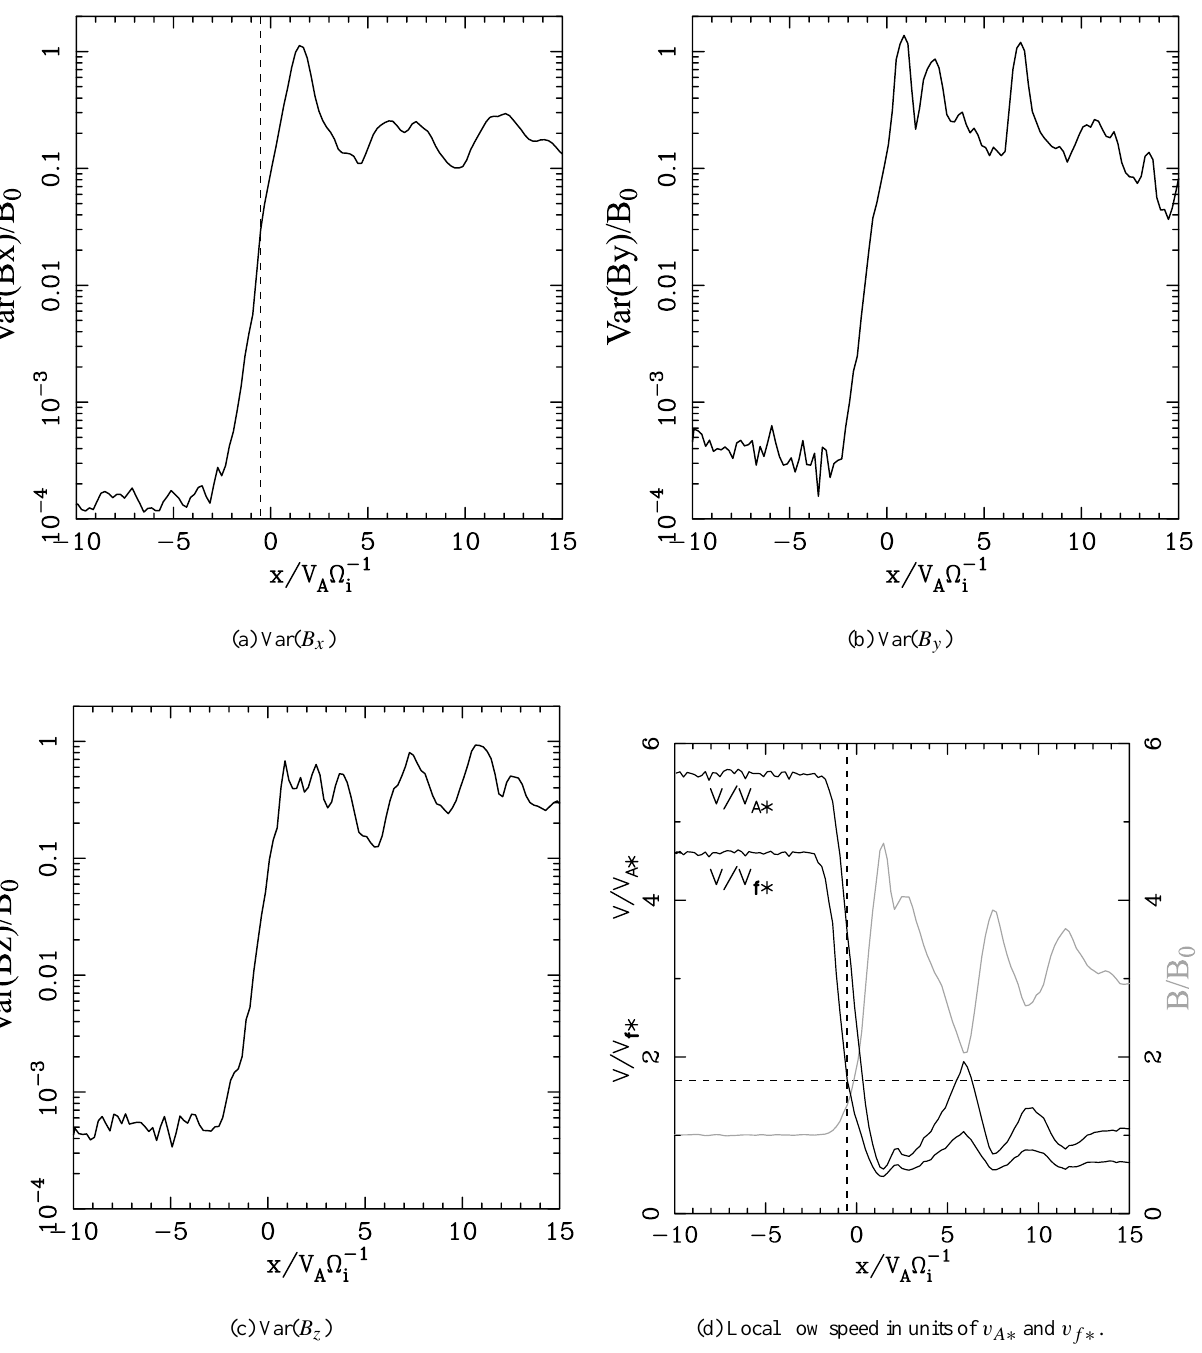
= 88 ◦ and M A ≈ 5 . 7. The flow n